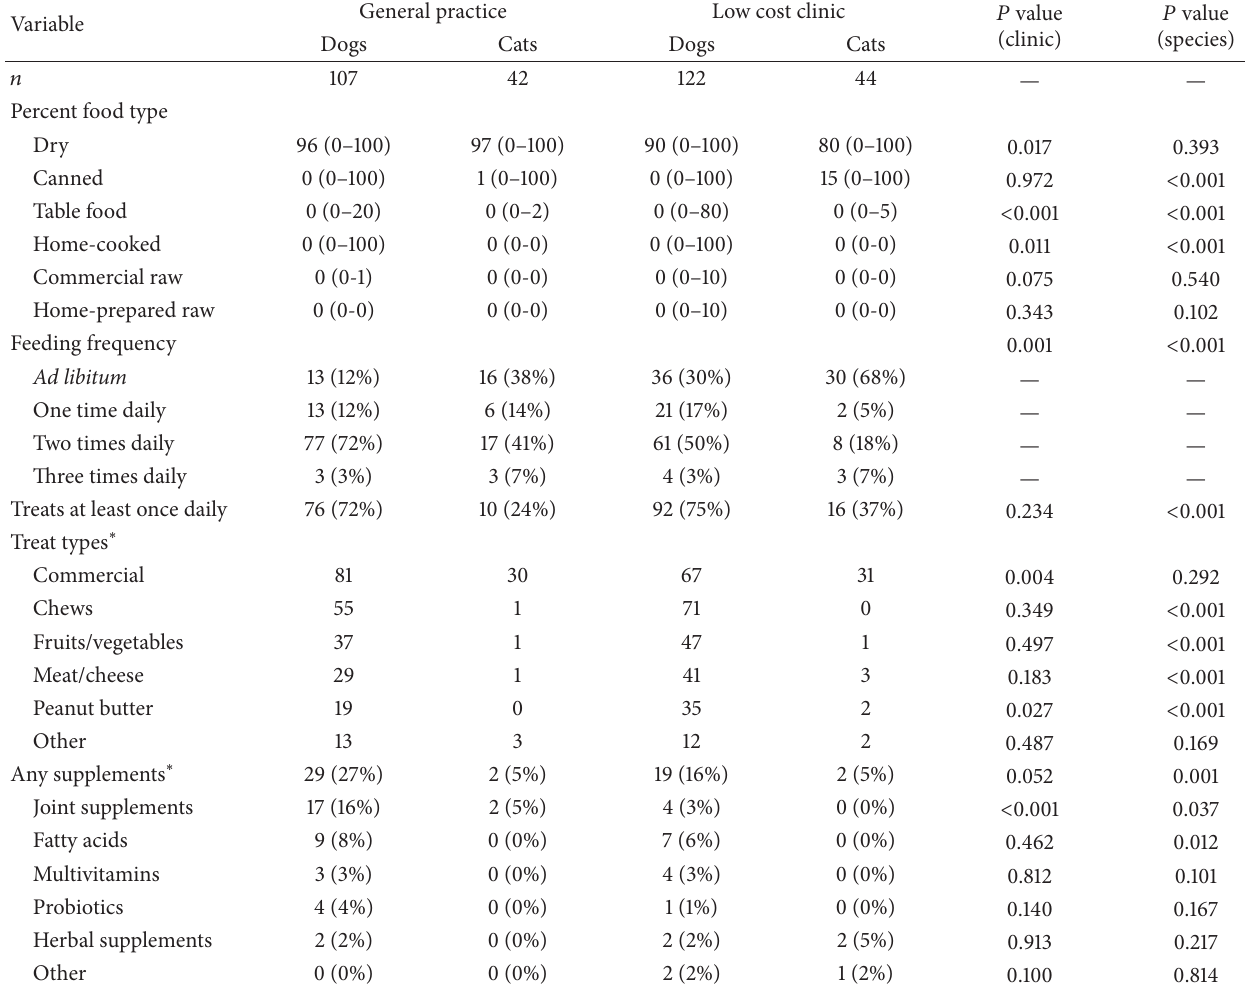
Table 4: Summary of responses from 229 dog and 86 cat owners from two veterinary clinics (general practice, 𝑛 = 149 ; low cost clinic, 𝑛 = 166 ). Number of owners providing each response, with percentage in parentheses or median (range).